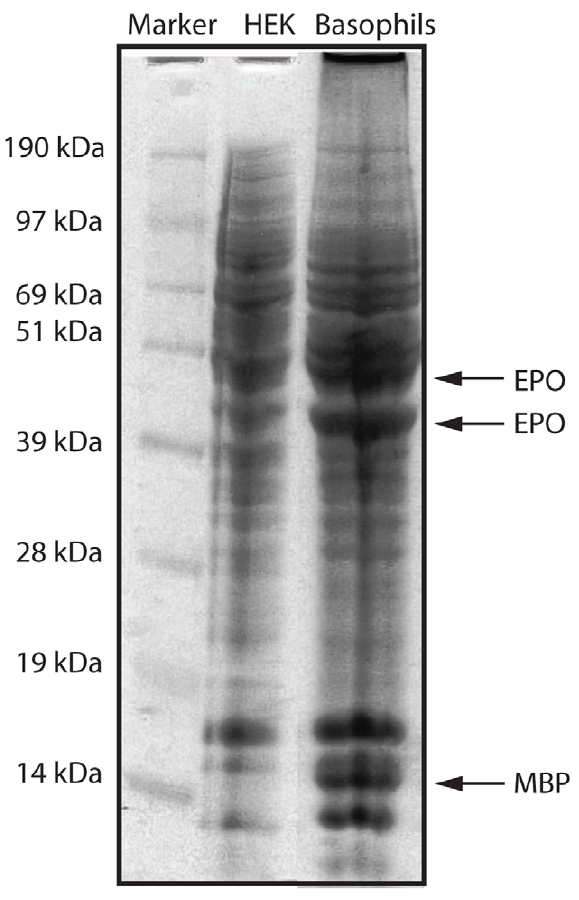
Figure 2. Analysis of the proteome of invitro differentiated basophils. SDS-PAGE analysis of human in vitro differentiated basophils. Approximately 1 million cells were dissolved in SDS-sample buffer and separated on a 13% SDS PAGE gel. As a reference the same number of cells from a human embryonic kidney cell line HEK 293-EBNA was used. The positions of three protein bands that were excised from the gel and analyzed by tryptic digestion and mass spectroscopy analysis are indicated by arrows and marked with the proteins identified in these bands: eosinophil peroxidase (EPO) and major basic protein (MBP).